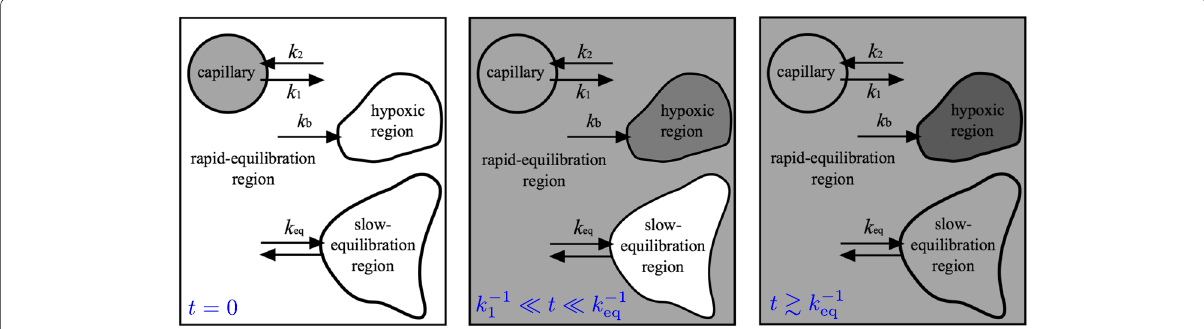
Fig. 4 Schematic of our partitioning model. From left to right: at t = 0 (left panel), tracer (gray-filled regions) is only in the capillary; for k − 1 1 (cid:6) t (cid:6) k − 1 eq (middle panel), tracer fills the rapid-equilibration regions and begins to bind where hypoxia arises; for t (cid:2) k − 1 eq (right panel),